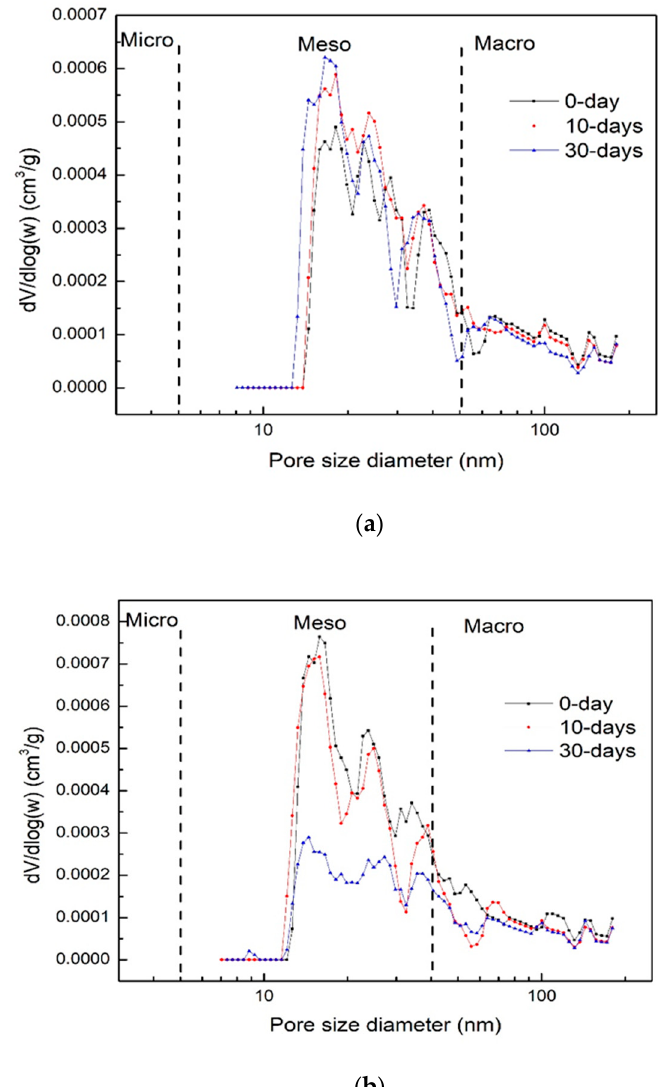
Figure 7. Pore size distribution (PSD) with Sc-CO 2 injection time variation. ( a ) sample at depth of 9848 ft; ( b ) sample at depth of 9850 ft.